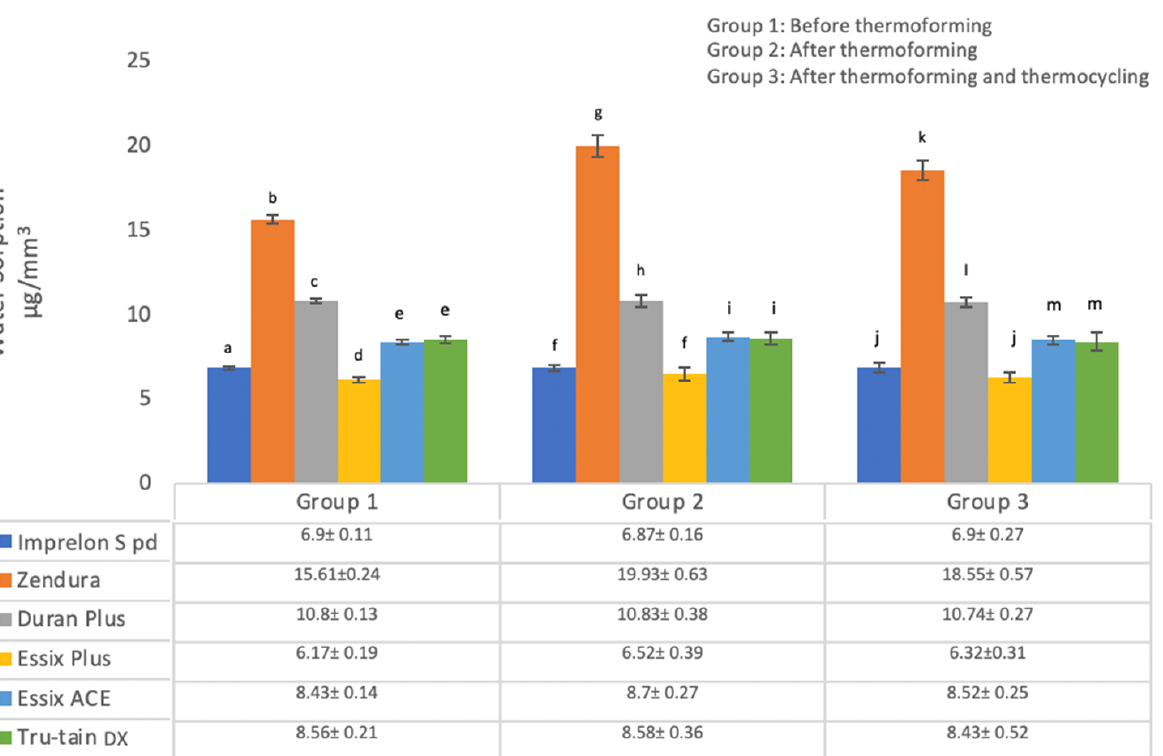
Figure 4. Comparison of the water sorption between the groups. Groups with similar small letters have no significant difference at ( p < 0.05).